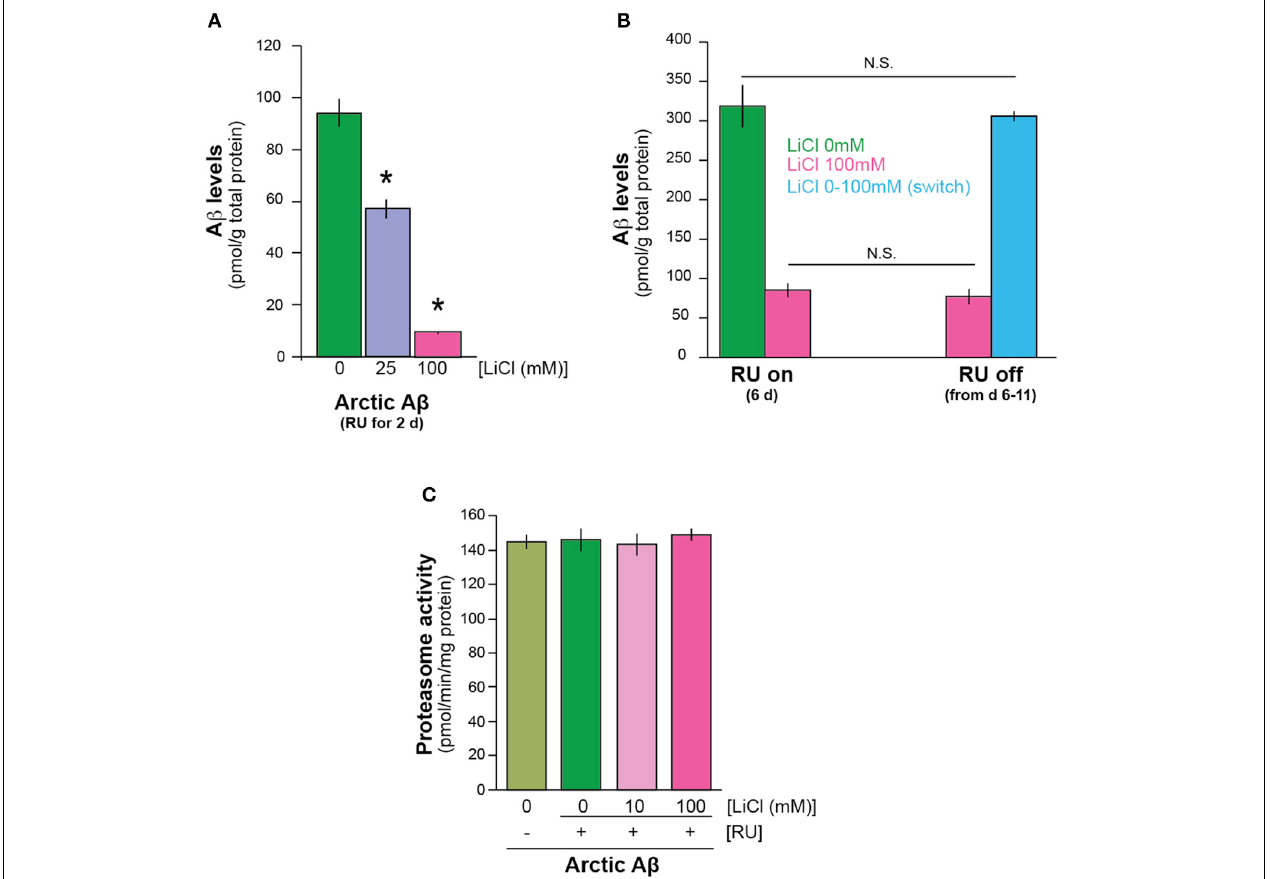
FIGURE 1 | Lithium reduced the level of A β 42 peptide in the adult Drosophila nervous system. (A) Lithium reduced amyloid levels of Arctic A β 42 flies at a very early time-point. Protein levels of UAS-ArcA β 42/ UAS-gfp ; elavGS/ + flies on + RU486 SY medium, and UAS-ArcA β 42/ UAS-gfp;elavGS/ + flies on + RU + lithium (LiCl), were measured by ELISA at 2 days post-induction (see Materials and Methods). Data were compared using One-Way ANOVA, number of independent tests ( n ) = 4. ∗ P < 0 . 01 and ∗ P < 0 . 001 when comparing UAS-ArcA β 42/UAS-gfp ; elavGS/ + + RU to UAS-ArcA β 42/UAS-gfp ; elavGS/ + + RU + LiCl 25 or 100mM respectively. (B) Protein levels of UAS-ArcA β 42/UAS-gfp ; elavGS/ + flies on RU + 100mM LiCl medium at 6 days post induction, and then switched to –RU